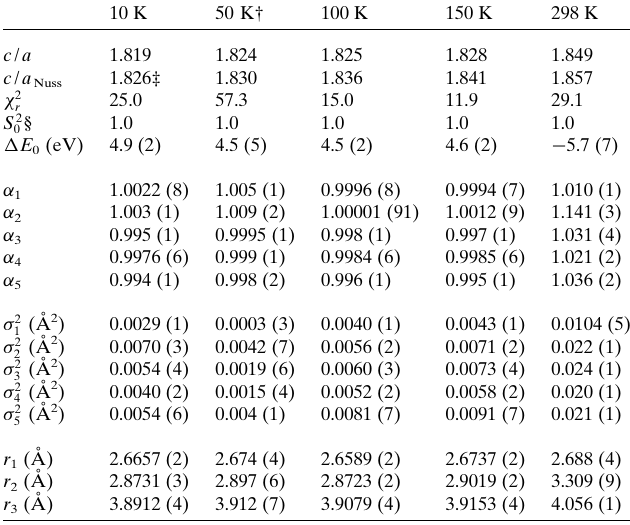
Table 3 eFEFFit